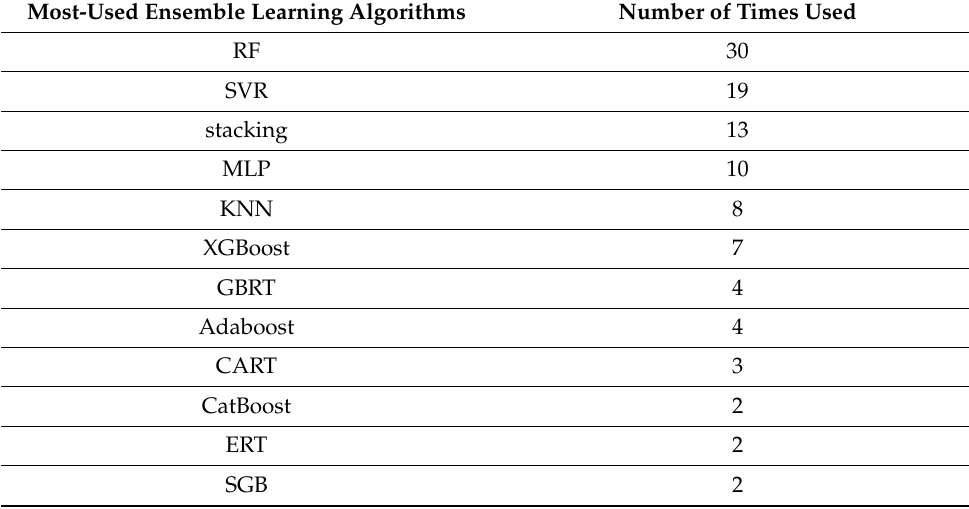
Table 3. Most-used ensemble learning